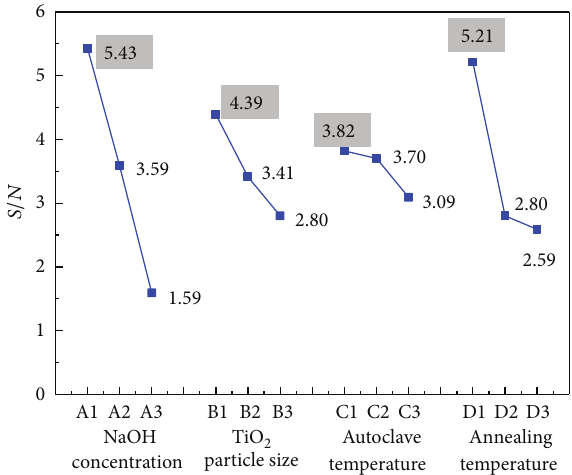
Figure 1: The factor effects on the 𝑆/𝑁